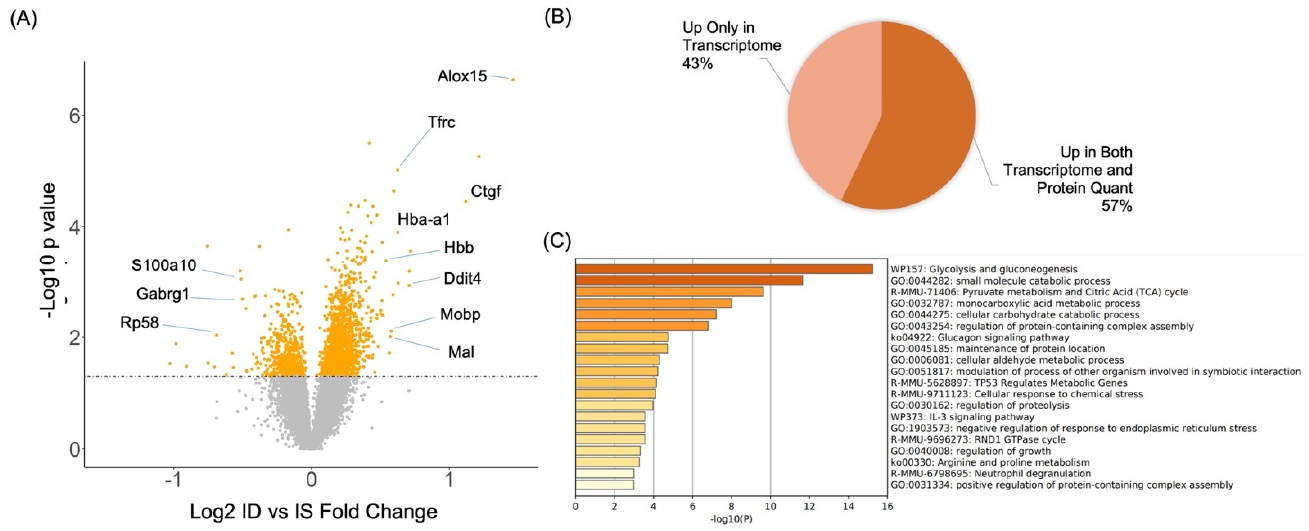
Figure 5. Gene expression analysis of ID-treated dynamics of transcriptome in postnatal day 15 rat hippocampus. ( A ) Volcano plot for transcriptome dynamic profiling of the rat hippocampus tissues. ( B ) Overlapping analysis between significantly upregulated genes in tissue with protein quantification data in cells. ( C ) Functional annotation enrichment of pathways and processes on proteins that were quantified to be upregulated based on both tissue and cell